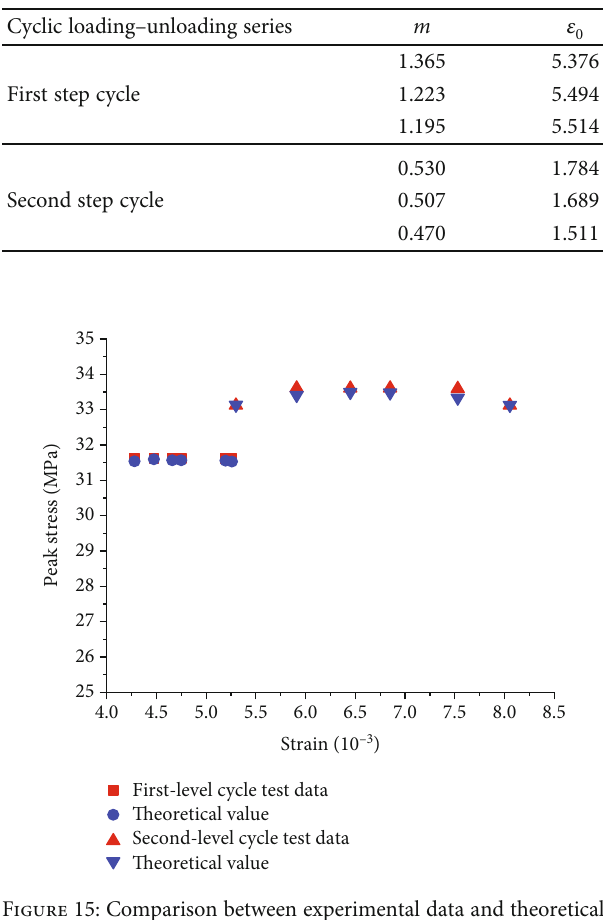
Table 2: Distribution parameters.